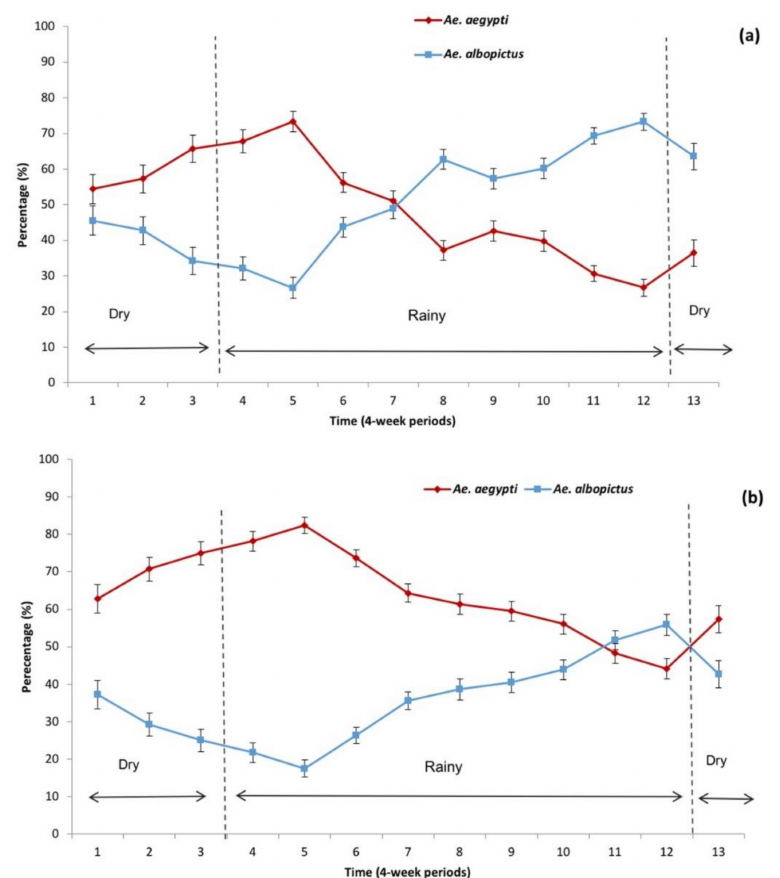
Figure 3. Mean percentage (+SE) of Aedes aegypti and Ae. albopictus reared from eggs collected from indoor and outdoor ovitraps per 4-week period during a three-year study in: ( a ) R í o Florido, ( b ) Hidalgo village. Four-week periods were based on the arrival of the rainy season (>100 mm precipitation/4-week) in each year of the